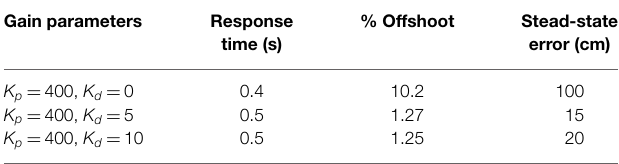
TABLE 1 | Test case of a wall in y direction